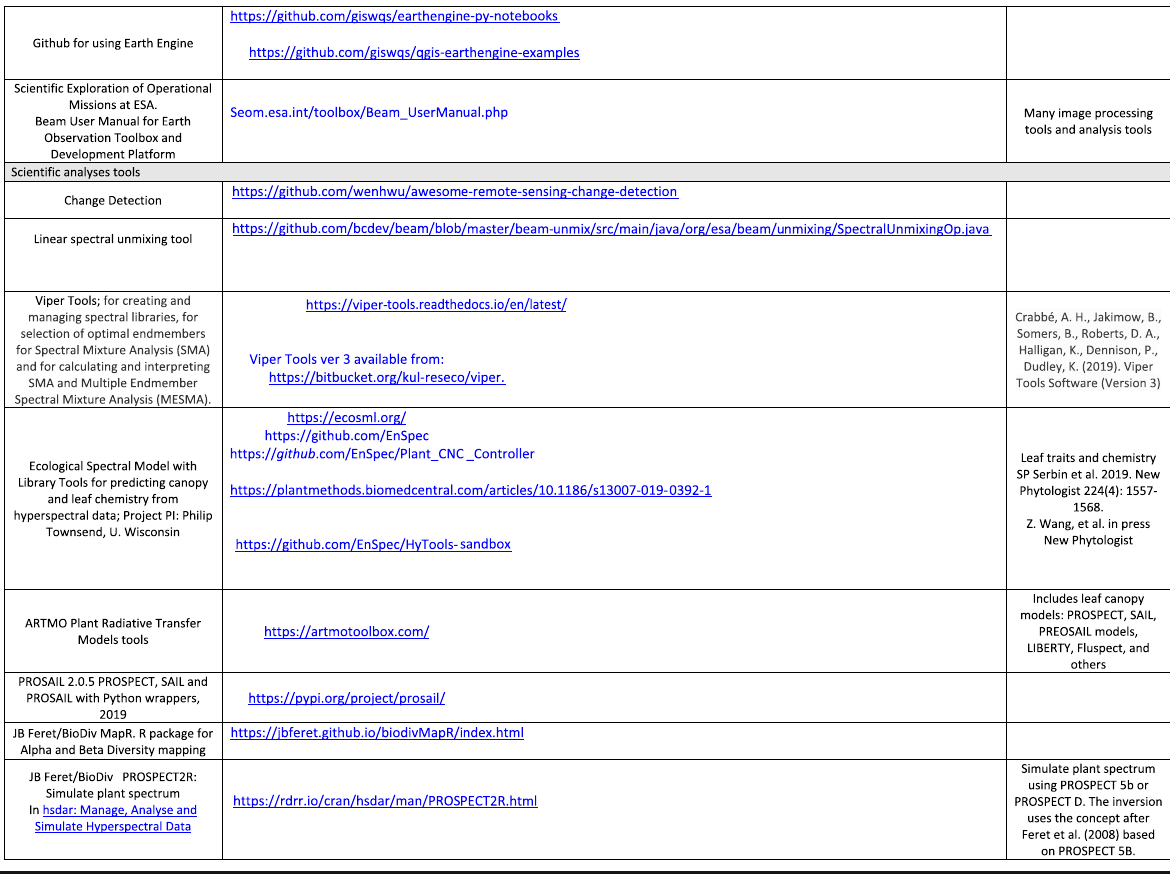
Table 7 Examples of Open Source Programs for Analyzing Satellite Data